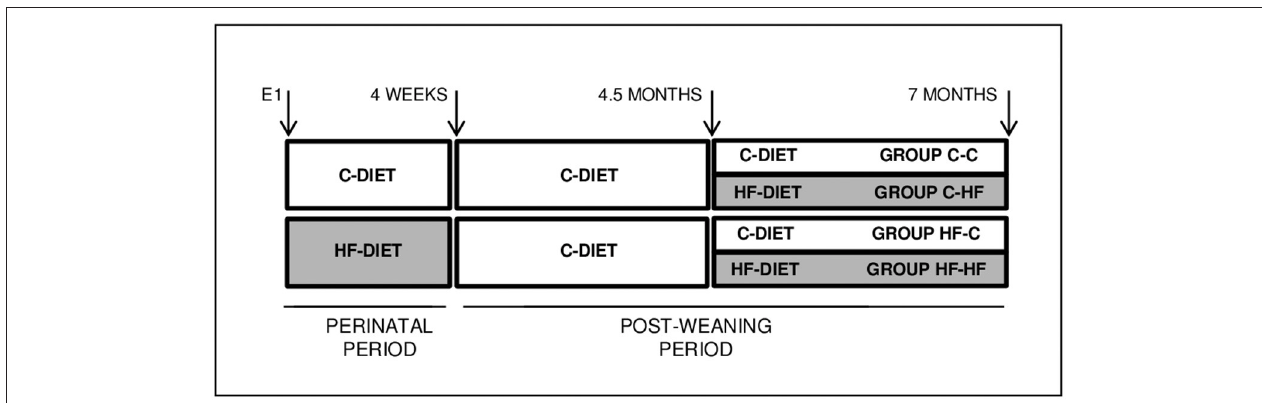
FIGURE 1 | Experimental scheme. Wistar female rats were fed a balanced C-diet (18, 23, and 59% of the energy content derived from lipids, proteins and carbohydrates, respectively) or unbalanced HF-diet (46, 16, and 38% of the energy content derived from lipids, proteins, and carbohydrates, respectively) during the whole perinatal period, from day 1 of gestation up till postnatal week 4. Pups were weaned on the C-diet. Adults of 4.5 months were either maintained on the C-diet or shifted to the HF-diet for 10 weeks. Animals were euthanazied at the age of 7-months after a 14–16-h overnight fasting. Groups were named according to their respective perinatal and adult diets, i.e., C-C, C-HF, HF-C, and HF-HF.